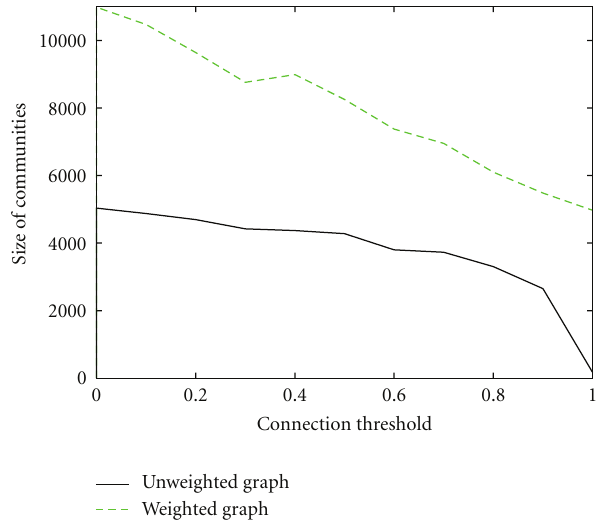
Figure 9: Size of communities on the Jester dataset, according to the connectivity threshold θ .